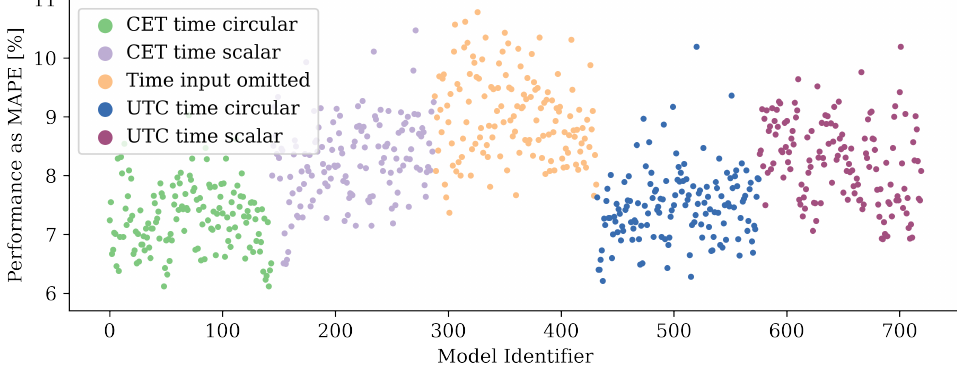
Figure 5. Performance of +2-models sorted and highlighted by their different time-of-day inputs. The two circular representation (green and blue) results in lower MAPE scores than omitting any time-of-day input